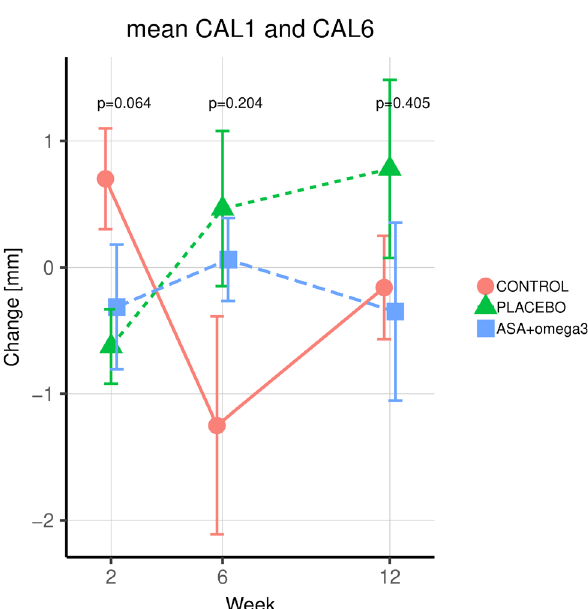
Fig. 4. Clinical attachment level. Difference between baseline measurements (Day 0) of CAL at locations 1 and 6 and PPD measured at 2 weeks, 6 weeks, or 12